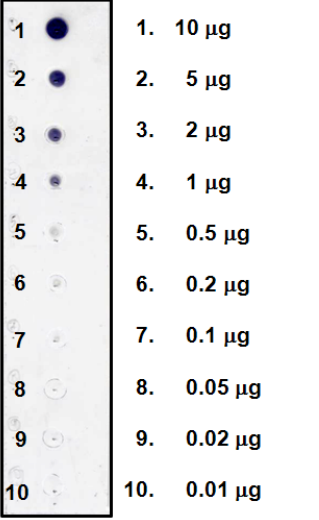
Figure 4. Dot blot analysis of BI and its detection limit.